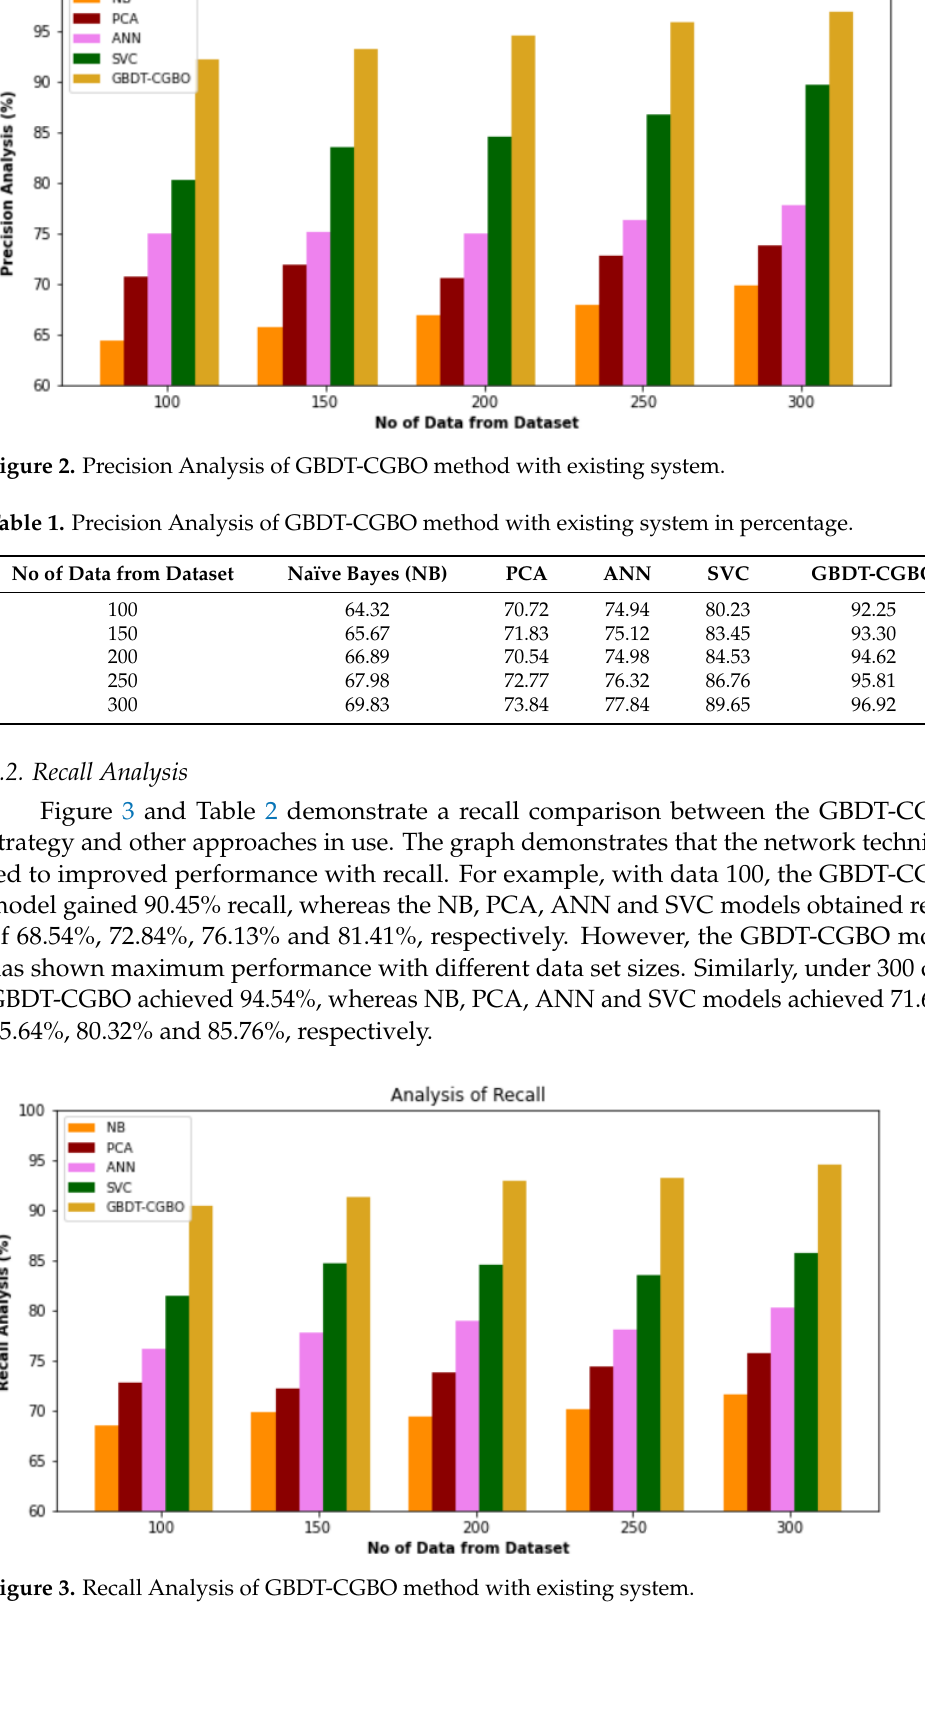
93.67 Figure 4. F-Score Analysis of GBDT-CGBO method with existing system.